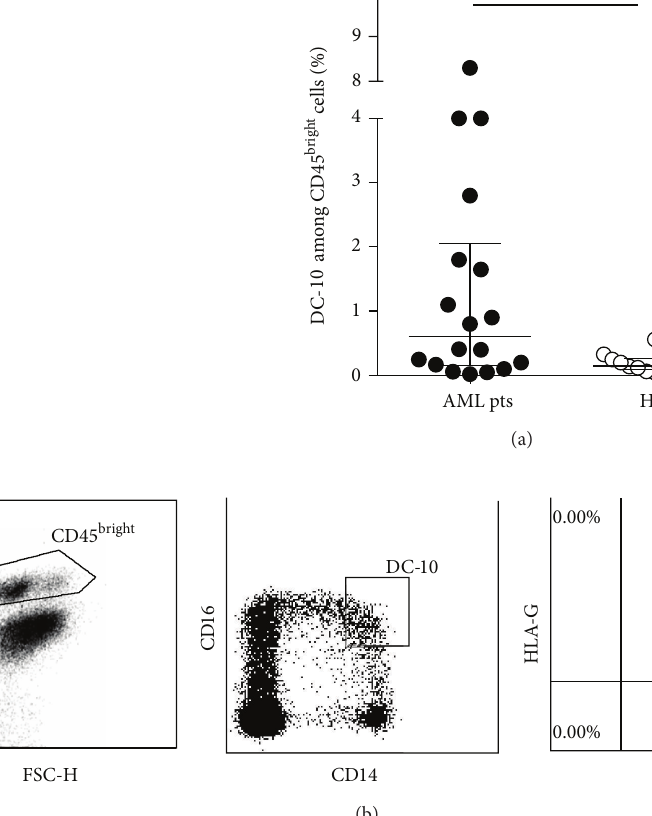
versus 0.19 ± 0.13 %, 𝑛 = 14 , mean ± SD; 𝑃 = 0.027 ; Figure 2(a)). The percentage of human DC-10 in AML